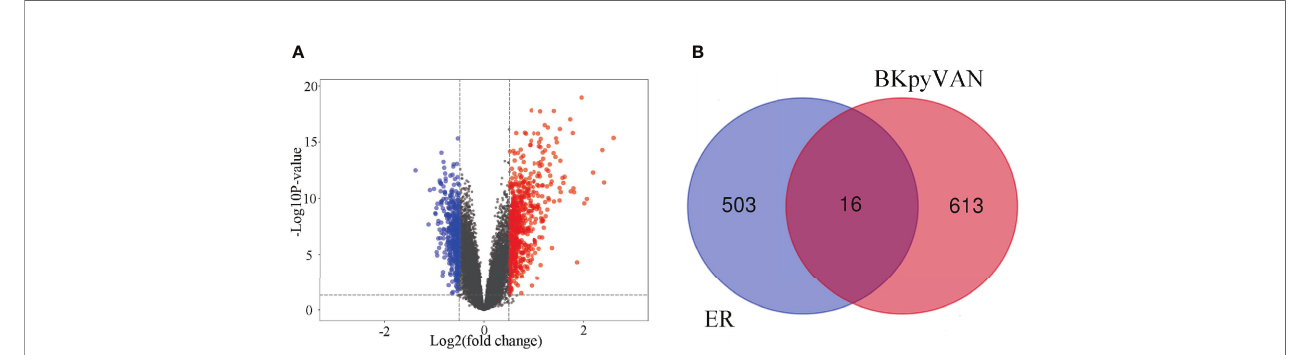
FIGURE 3 | Prediction of BKPyV-related genes and endoplasmic reticulum-related genes. (A) Volcano plot shows that differentially expressed genes (DEGs) between BKPyVAN and stable transplanted kidney [BKPyVAN=28, stable transplanted kidney=109, p-value < 0.01 and | fold change (FC)| > 1.5]. The blue part indicates the downregulated genes. The red part represents the upregulated genes. The black part shows the stable genes. (B) Venn diagram identi fi es genes related to BKPyVAN and endoplasmic reticulum.